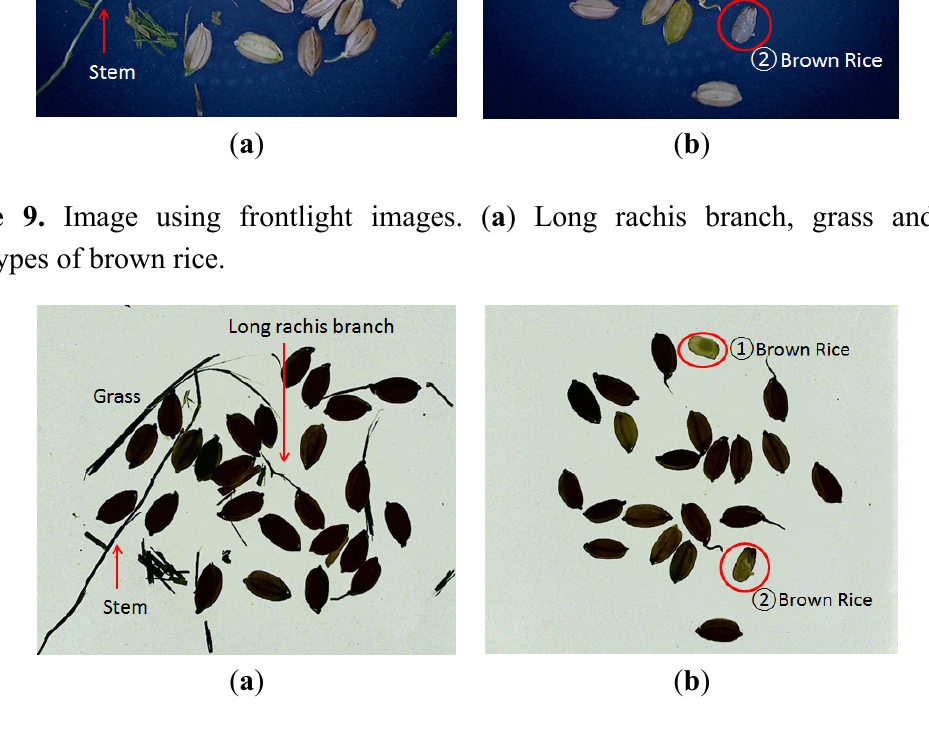
Figure 10. Image using backlight images. ( a ) Long rachis branch, grass and stem; ( b ) 2 types of brown